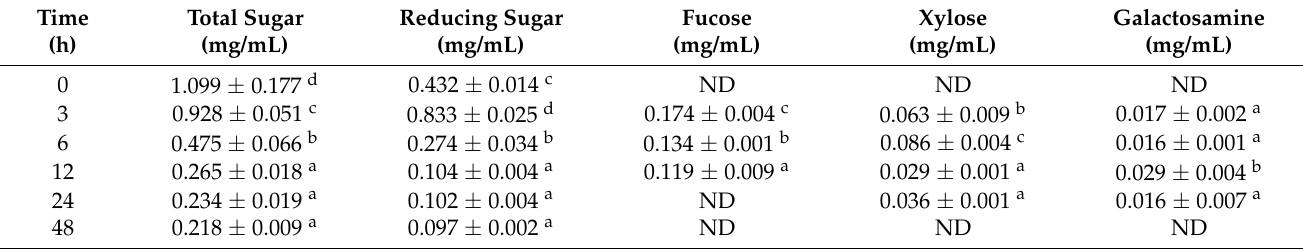
Table 1. Changes in total sugar, reducing sugar and free monosaccharide contents for in-vitro